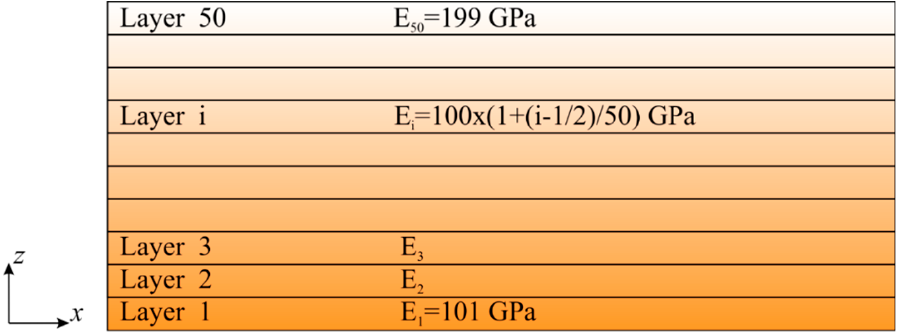
Figure 4. Simply supported functionally graded Mindlin plate. Figure 5. Numerical discretization, loading and fictitious region. Assuming the coordinate system is attached at the geometric centre of the plate, the following boundary conditions are applied in ANSYS: u (cid:3436)− 𝐿 2 , 𝑦, 0(cid:3440) = u (cid:3436)𝐿 2 , 𝑦, 0(cid:3440) = u (cid:3436)𝑥, − 𝑊 2 , 0(cid:3440) = u (cid:3436)𝑥, 𝑊 2 , 0(cid:3440) = 0